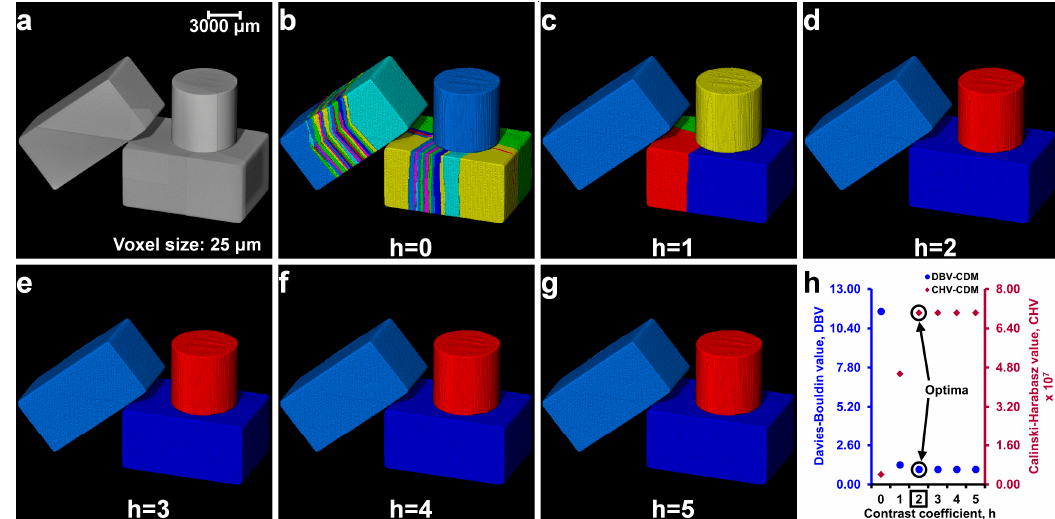
Figure 2. Determination of the optimal contrast coefficient, h, for three regular shaped blocks in contact: ( a ) greyscale volume; ( b – g ) separation results (labelled volumes) for different h -values ( h = 0 to 5) with the Chamfer distance map (CDM); and ( h ) cluster evaluation criteria values with the optimal h -value (square marked).